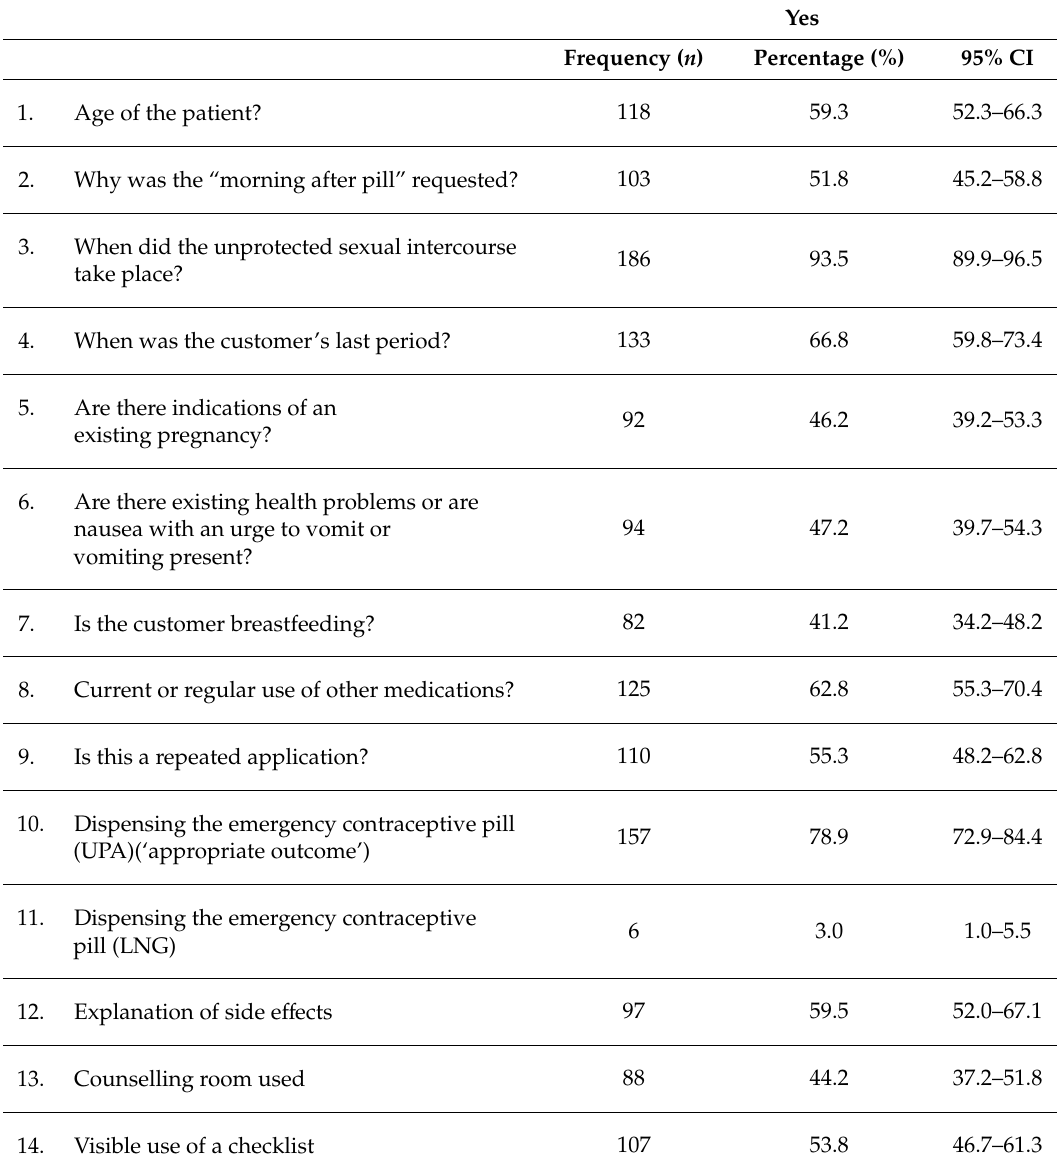
Table 5. Assessment items ( n =